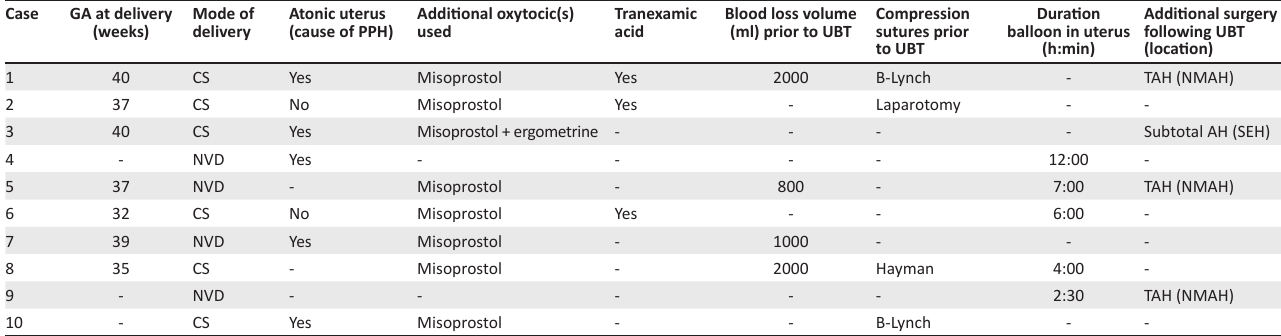
TABLE 1: Details of patients who had uterine balloon placements. Case GA at delivery